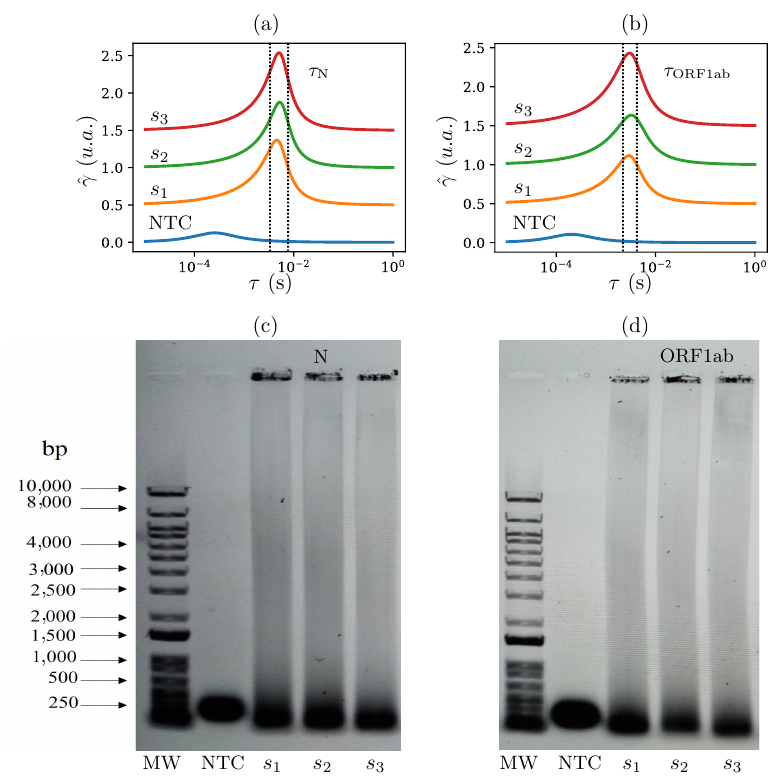
Figure 4. Detection of SARS-CoV-2 genome using a negative control (NTC) and three positive samples s 1 , s 2 and s 3 . ( a , b ) TCDS signals for genes N and ORF1ab, respectively. ( c , d ) Gel electrophoresis of the RT-LAMP reaction for genes N and ORF1ab,